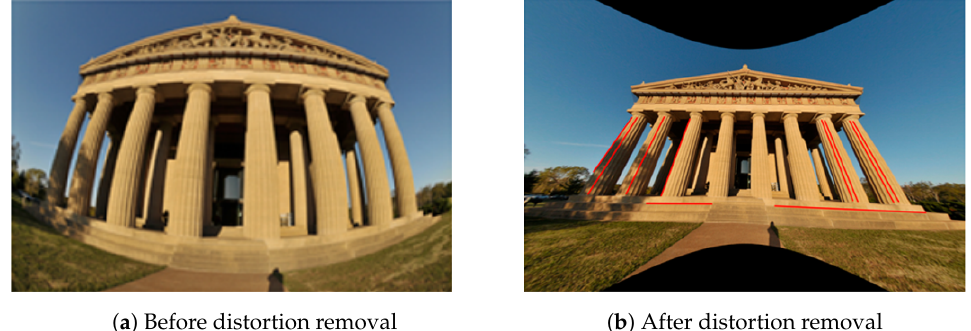
Figure 11. Illustrations between image before and after distortion removal. The red lines represent straight lines/structures in real world. Adapted from [46].